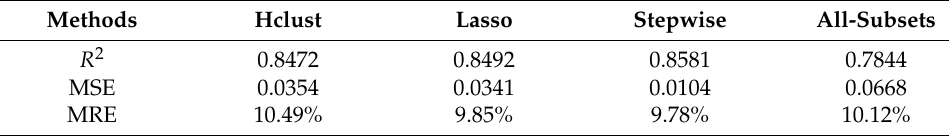
Figure 8a–c are histograms of 𝑅 (cid:2870) , MSE, and MRE on the test set, respectively. It can